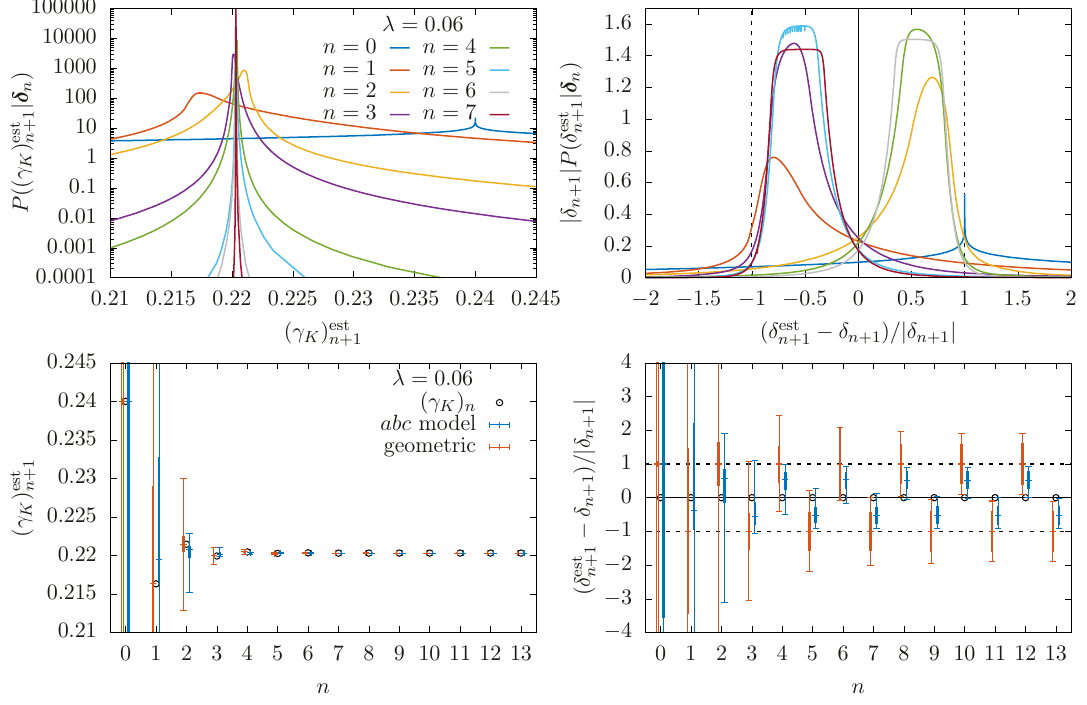
Figure 5 . Top left panel: the probability distribution from the abc -model for the cusp anomalous dimension ( γ ) est in planar N = 4 SYM for λ = 0 . 06 and for different values of n . Top right panel: K n +1 the same distributions normalised to the exact N n +1 LO correction. Bottom left panel: the median (plus), 68% CI (errorbox) and 95% CI (errorbar) for the posterior of ( γ abc (blue) and geometric (red) models using information on the previous orders. The exact value of ( γ ) is shown as black circles. Bottom right panel: CIs scaled to the exact N n +1 LO K n